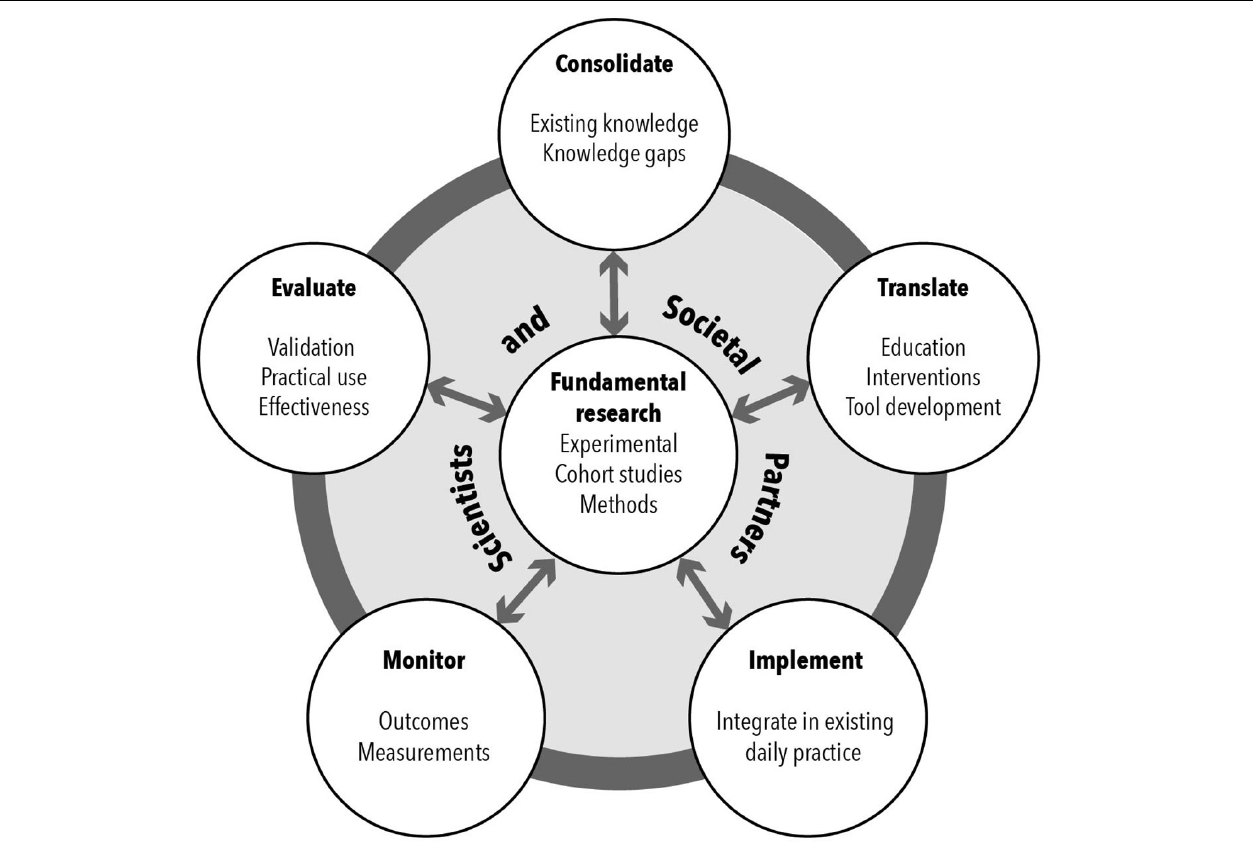
FIGURE 2 | Integrating fundamental research in society at different levels. Fundamental research can have different goals as to how findings may be integrated in society. Depending on the purpose of the project, one can integrate findings by: consolidating knowledge (e.g., exchanging knowledge with stakeholders), translating knowledge (e.g., educational modules), implementing knowledge (e.g., integrate interventions in daily practice), monitoring knowledge (e.g., checking whether scientific knowledge is used properly, and fits with stakeholders’ goals), and evaluating knowledge (e.g., evaluating whether scientific knowledge is effectively used). The process is iterative and dynamic: knowledge is integrated from fundamental research to society and back. Importantly, societal partners and a diverse team of researchers should be involved to guarantee successful implementation. This model is based on Nauta-Jansen